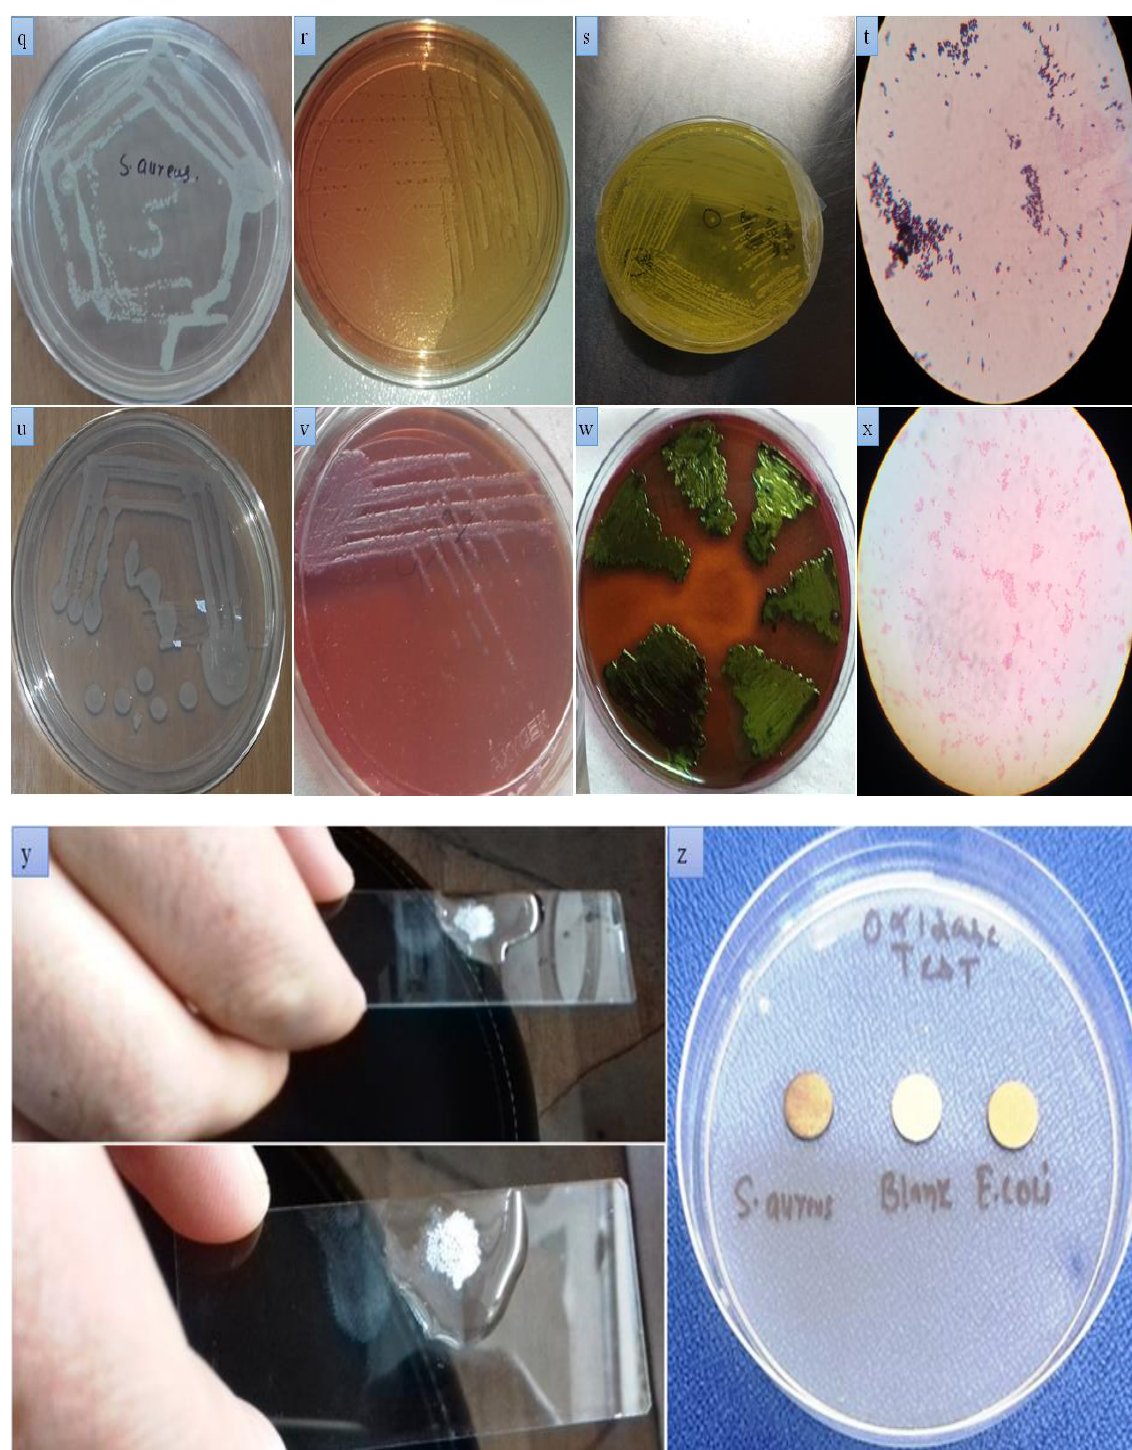
Figure 5. S. aureus and E. coli on basal and differential media : n utrient agar ( a – d ); brain – heart infu-